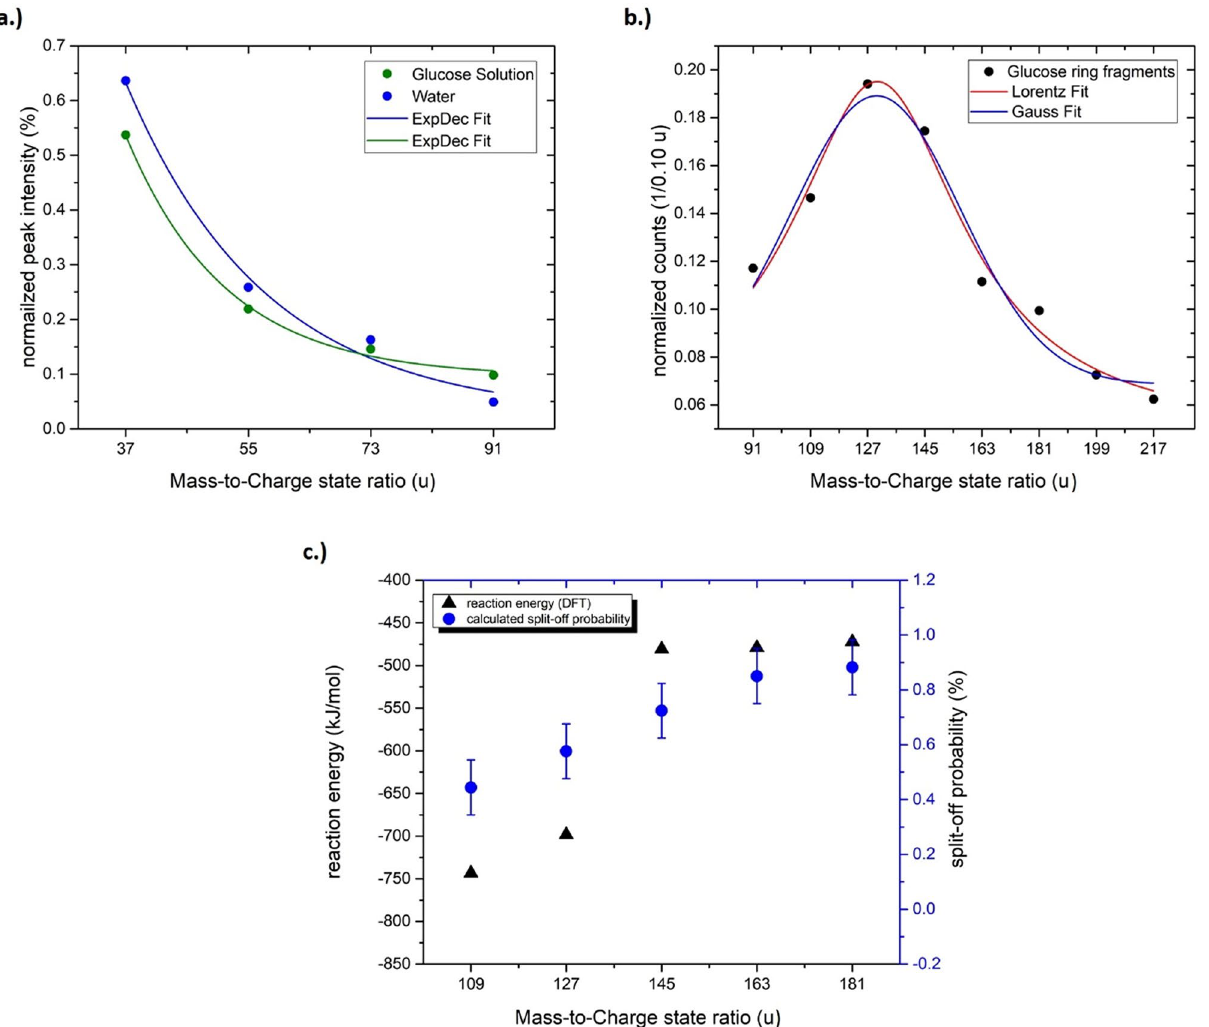
Figure 3. In ( a ) the relative peak intensity of the water molecules (H 2 O) n H + with n = 1–5 from a pure water measurement and the glucose solution, in ( b ) the peak distribution of the peaks of the glucose ring from m/z = 91 up to 217 u and in ( c ) the calculated probabilities (Table 2) and the reaction energy calculated by DFT to remove one HO + H from a glucose ring-/fragment are plotted against the respective mass-to-charge state